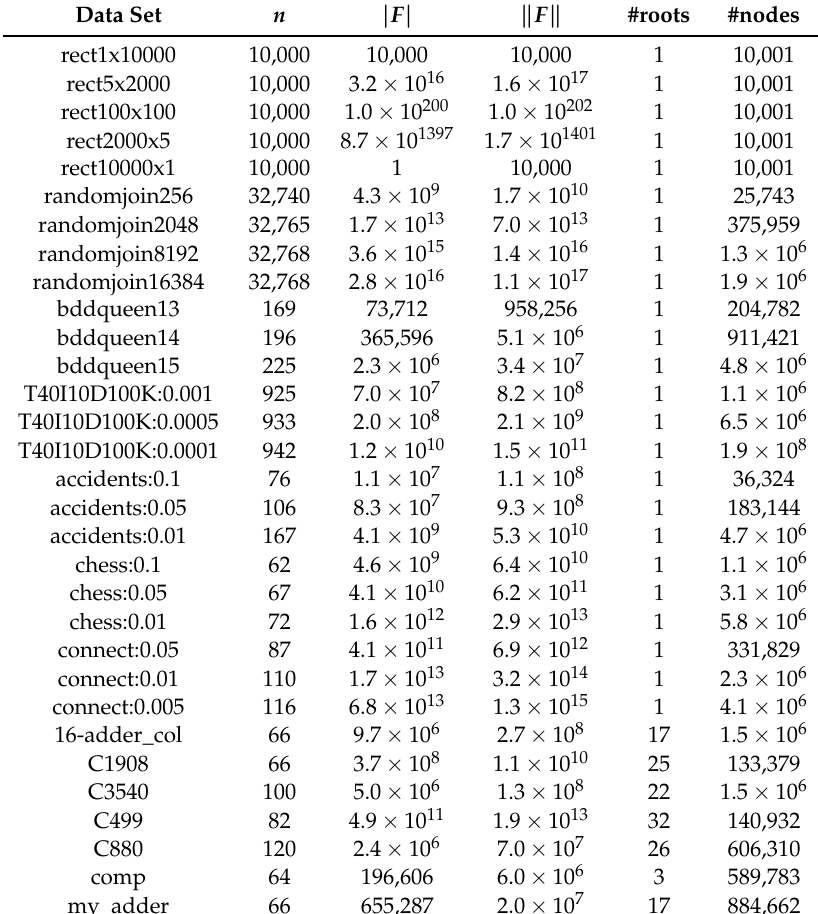
Table 2. Detail of data sets and their ZDD